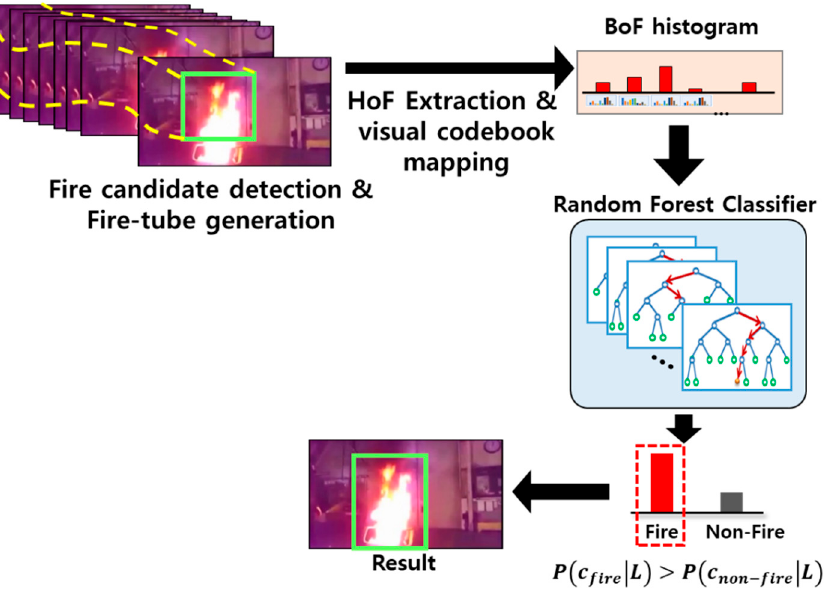
Figure 5. Fire verification procedure at test time. From the fire-tube, the BoF is generated through the same training and is input to the RF for final fire verification.